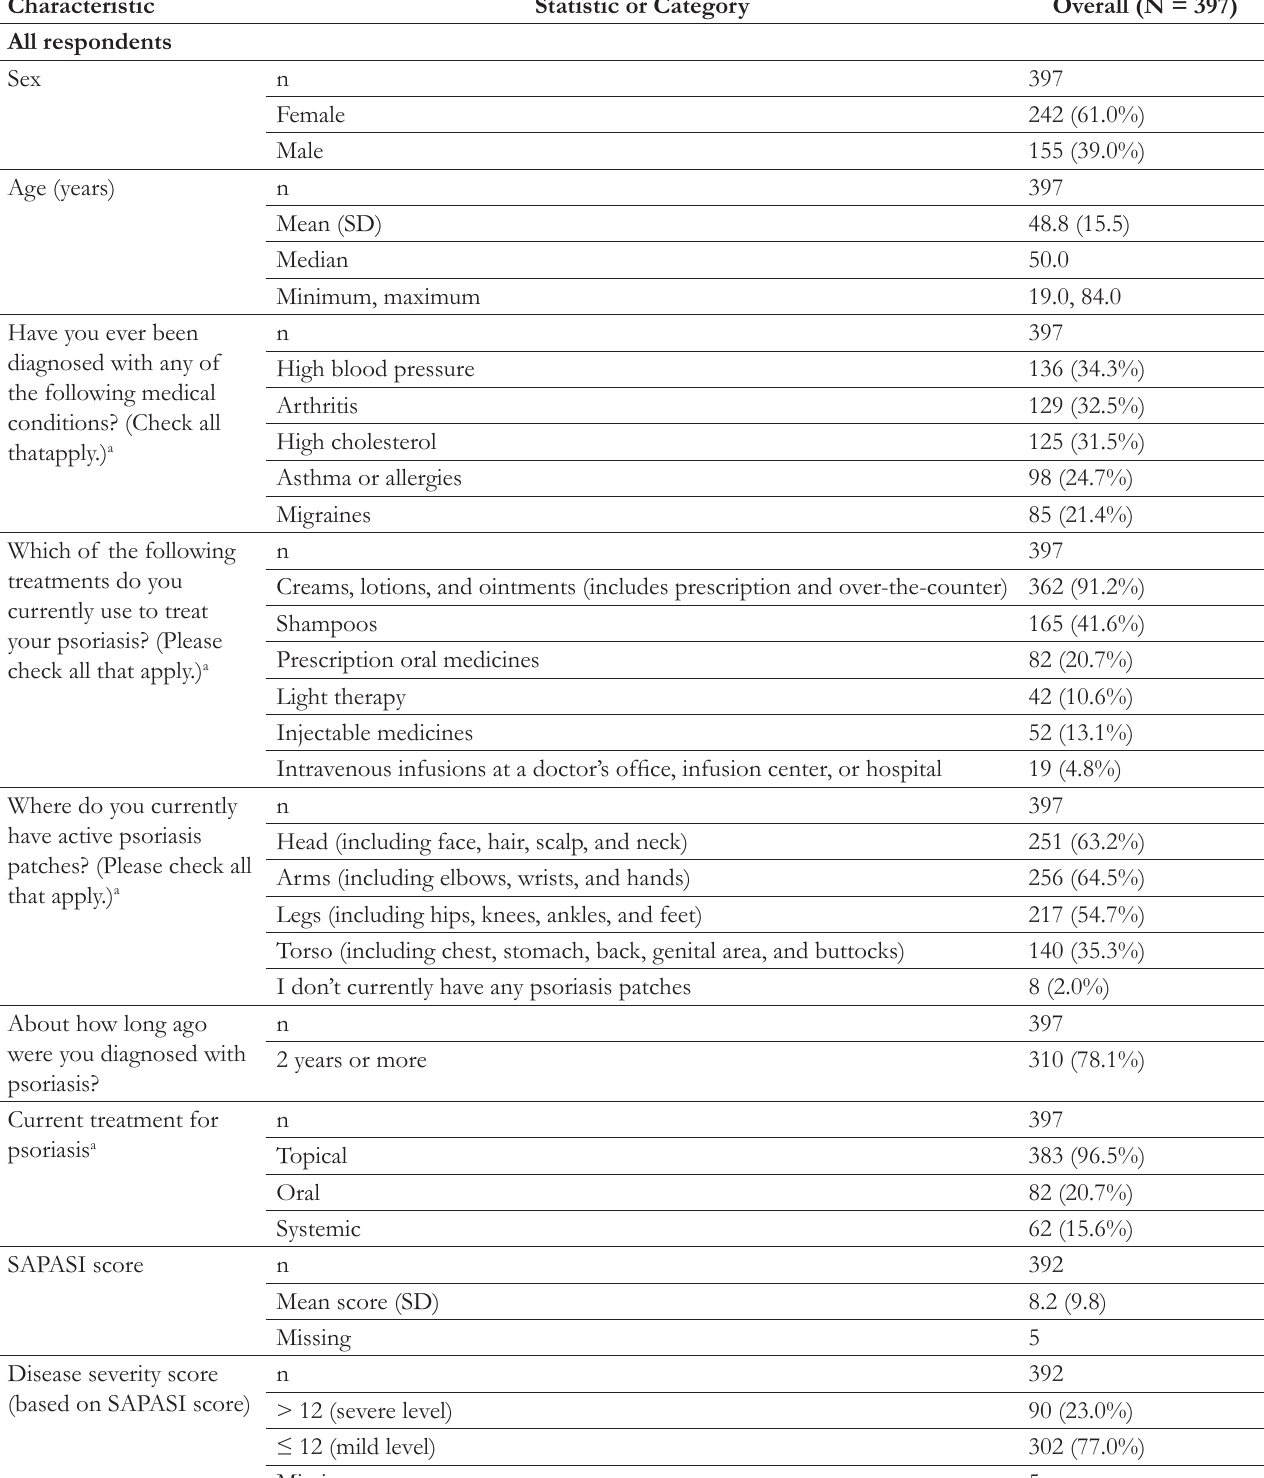
Table 2. Patient Sample Characteristics (N = 397) Characteristic Statistic or